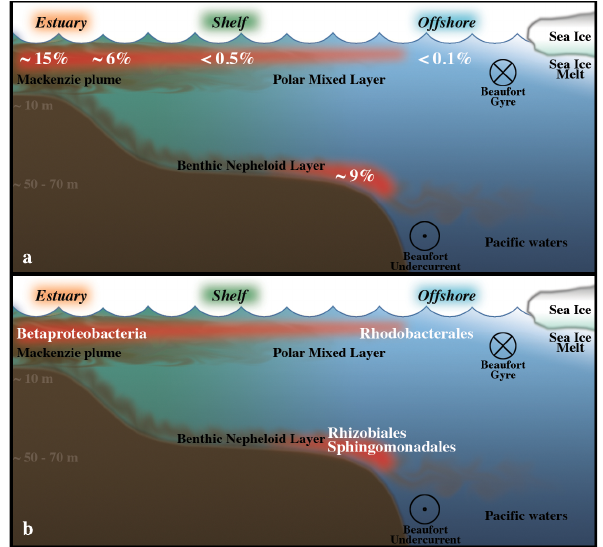
Figure 3. Schematic diagram representing the changes in abun- dance (a) and diversity (b) of major AAP bacterial clades along an onshore–offshore transect of the Beaufort Sea. AAP proportions were calculated by dividing AAP bacterial numbers (enumerated by infrared epifluorescence microscopy) by the total prokaryotic num- bers (4’,6-diamidino-2-phenylindole